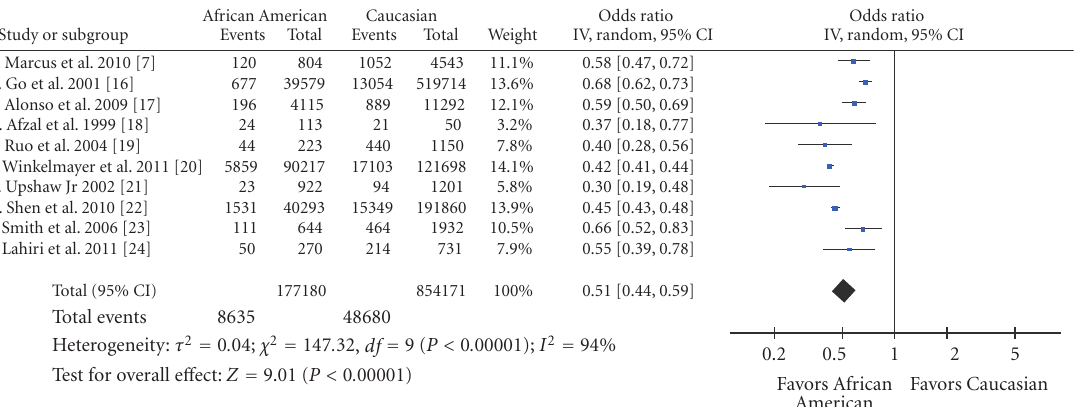
Figure 2: Meta-analysis of the association between African American race and prevalence of atrial fibrillation. The squares represent the odds ratio and their sizes are proportional to the study sample; the horizontal lines represent 95% confidence intervals